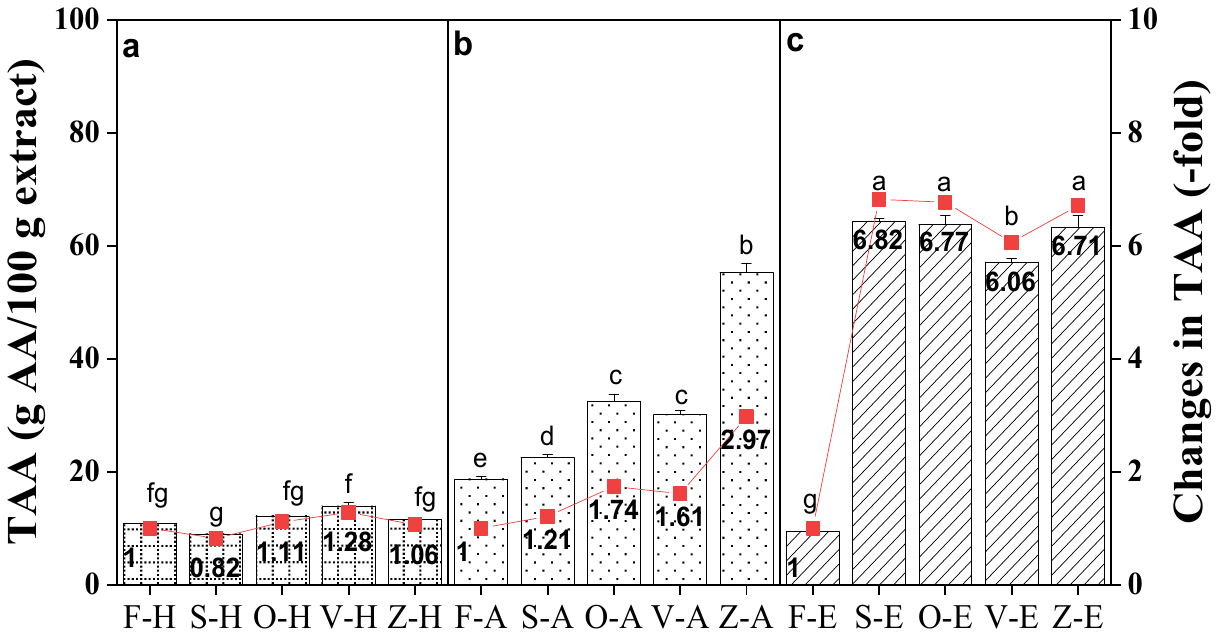
Figure 3. Total antioxidant activity (TAA) of Bentong ginger extracted using ( a ) hot water (H), ( b ) aqueous (A), and ( c ) ethanol (E) solvents via sun (S)-, oven (O)-, vacuum (V)- and freeze (Z)-drying methods. Fresh ginger (F) was used as the control. Changes were calculated based on the respective fresh ginger samples. Bars with different letters are significantly different. Sample F-H = Fresh ginger (Control) with hot water, and sample Z-E is freeze-drying with ethanol. For ethanol extracts, TAA increased significantly after being dried with sun-drying, showing the highest increment at 6.82-fold, followed by oven-drying (6.77-fold), freeze-drying (6.71-fold) and vacuum-drying (6.06-fold). As for aqueous ethanol extracts, TAA of the freeze- dried samples exhibited the highest increase at 2.97-fold, followed by ovendrying (1.74-fold), vacuum-drying (1.61-fold) and lastly, sun-drying (1.21-fold). In hot water extracts, the TAA of extracts post-drying increased slightly (approximately 1-fold) for all drying methods, except sun-drying (0.82-fold), suggesting a decrease in antioxidant